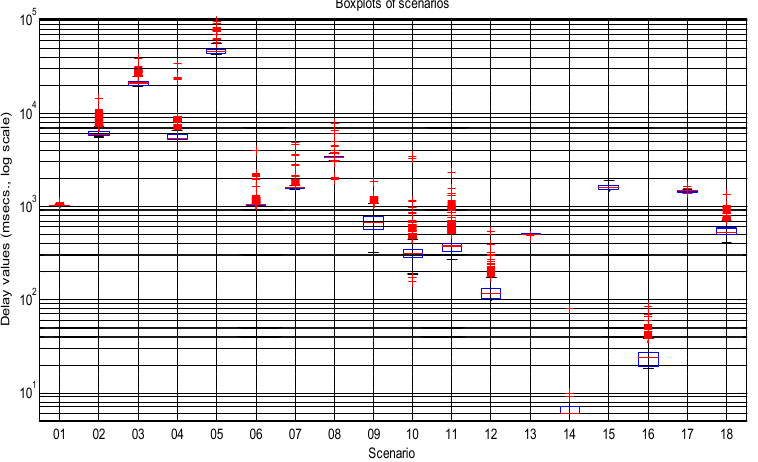
Figure 3. Boxplots of the scenarios of Figure 2. The y-axis is shown in logarithmic scale to appreciate better the amount of delay values (red markers) that are above the principal quartiles (blue boxes), which demonstrates the skewness of the marginal